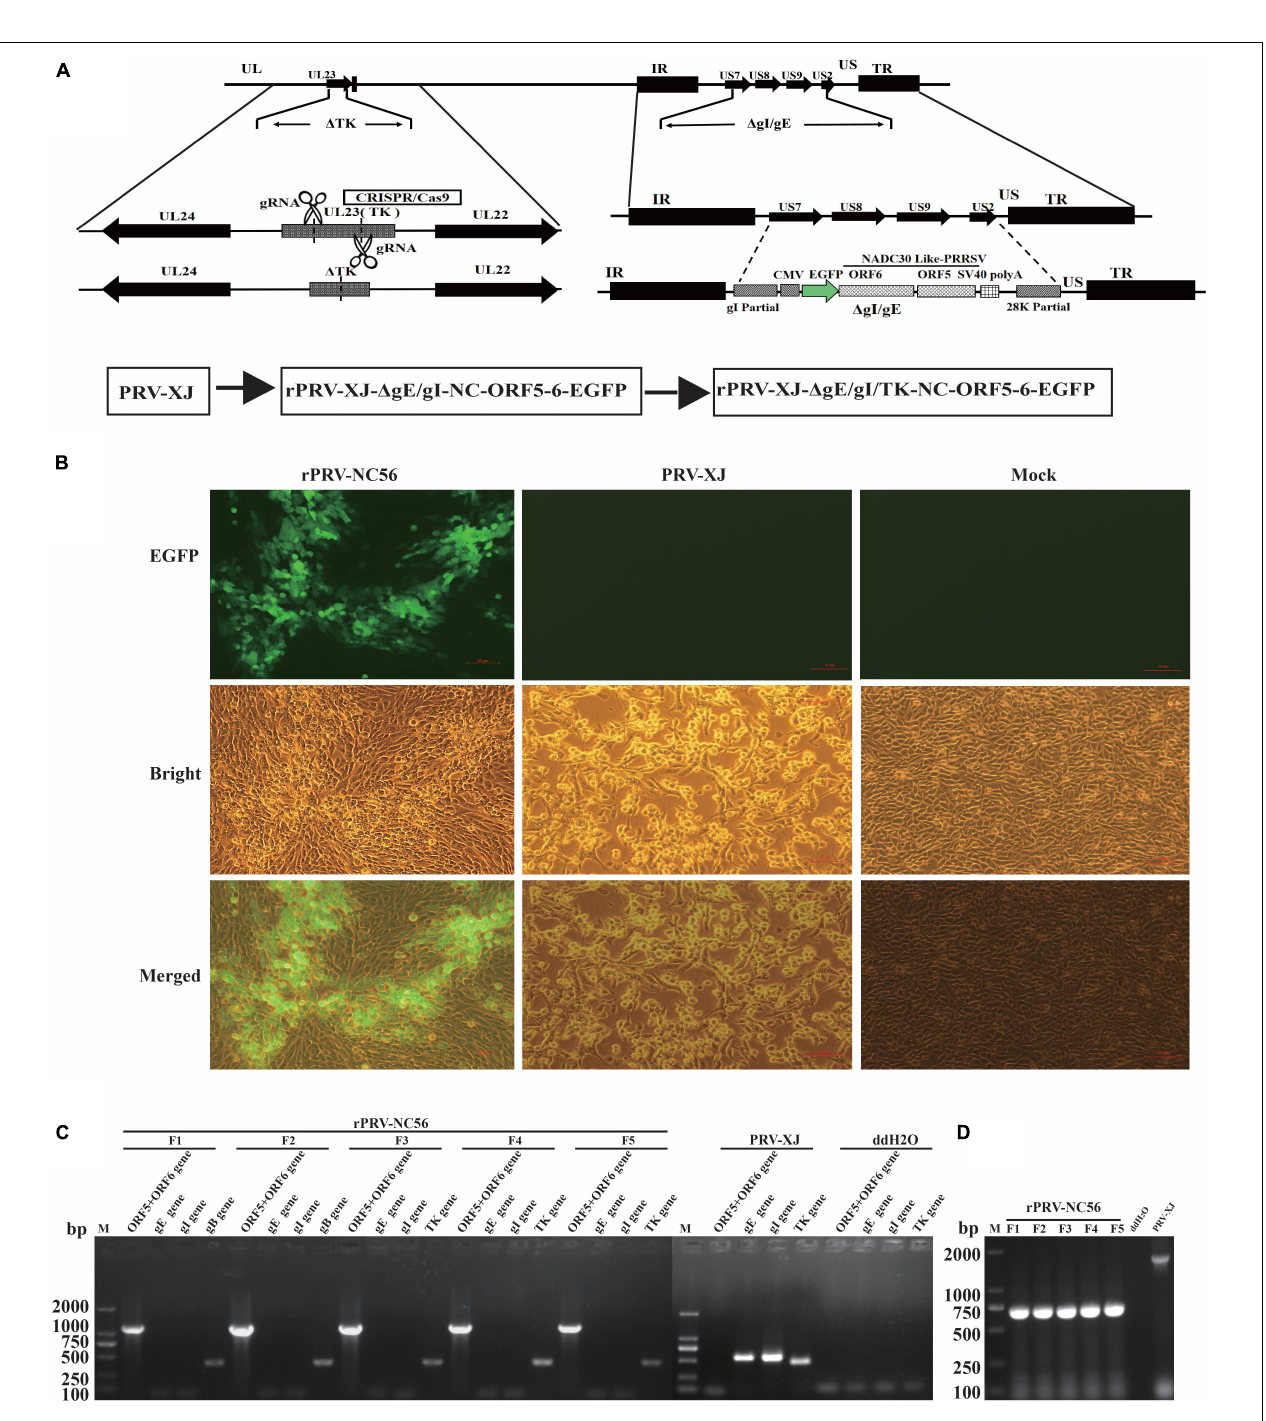
FIGURE 1 | Construction of recombinant pseudorabies virus (rPRV)-NC56. (A) Schematic diagram of recombinant pseudorabies virus (PRV) construction strategy. (B) Baby hamster Syrian kidney (BHK-21) cells infected with rPRV-NC56 and PRV XJ were observed under fluorescence microscope. (C) PCR identification results of the gE, gI, gB, TK, and partial inserted target genes (ORF5-6) of rPRV- (cid:49) gE/gI-NC-ORF5-6 cultures. (D) PCR identification of the CRISPR/Cas9 deletion of the TK gene.